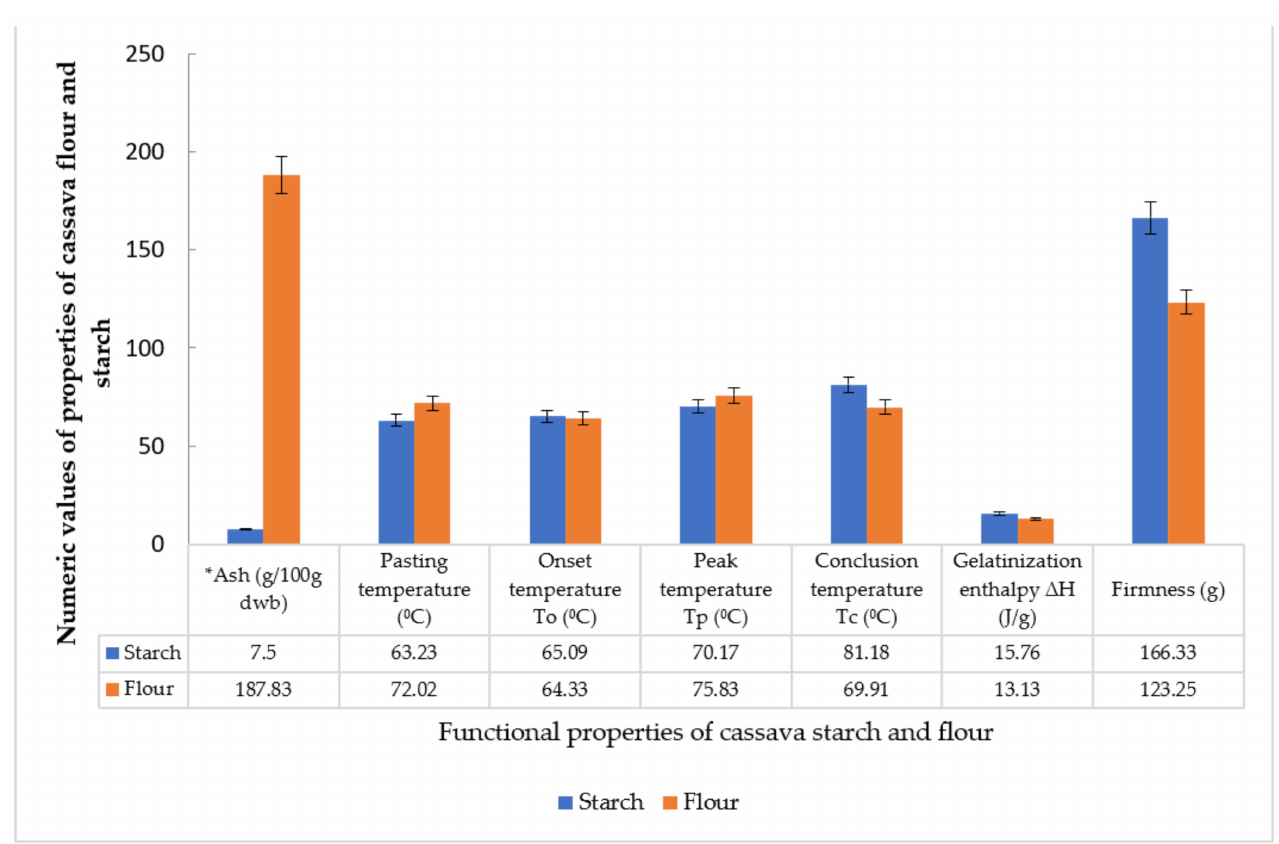
Figure 2. Functional properties of cassava starch and their corresponding flour. All values are average values obtained from 12 varieties of cassava; * actual values in the column were multiplied by 100. Adapted from